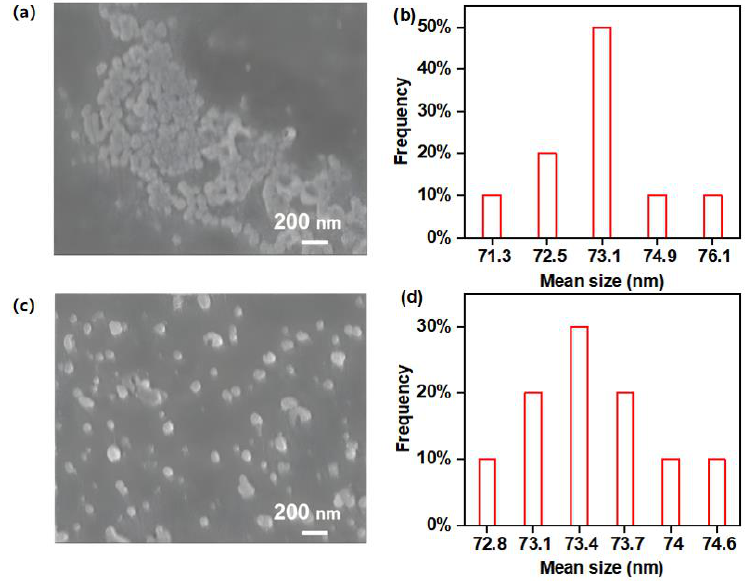
Figure 2. SEM images of l -PAnTPE ( a ) and PAnTPE ( c ), and particle size distributions of l -PAnTPE ( b ) and PAnTPE ( d ).